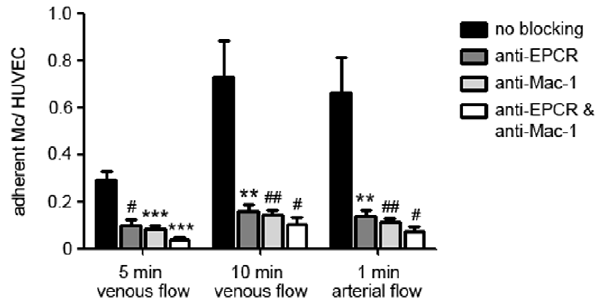
Figure 4. Blockade of monocyte binding to endothelial cells by anti-EPCR and anti-Mac-1 under flow conditions. Monocyte binding to HUVECs in a dynamic adhesion assay after 5 min (left) and 10 min venous flow (middle), and after 1 min arterial flow (right). When EPCR was blocked on HUVECs (dark grey bars), Mac-1 on monocytes (light grey bars), or both (white bars) monocyte binding could be significantly diminished compared to native cells without antibody treatment (black bars). (*** p , 0.0001; ** p , 0.001; ## p , 0.005; # p , 0.05 vs. no blocking).